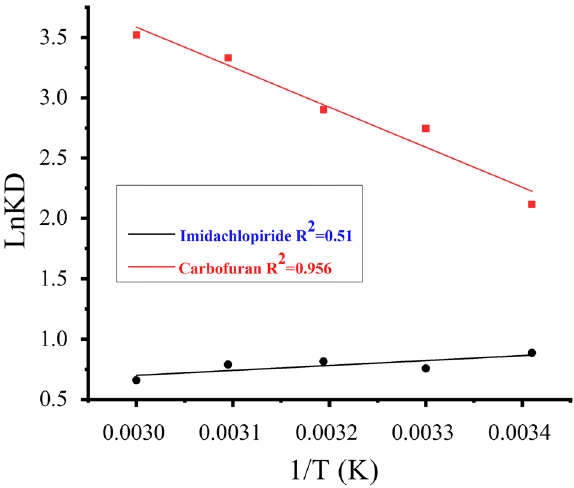
Figure 10. Van’t Hoff equation for the adsorption of imidacloprid and carbofuran.